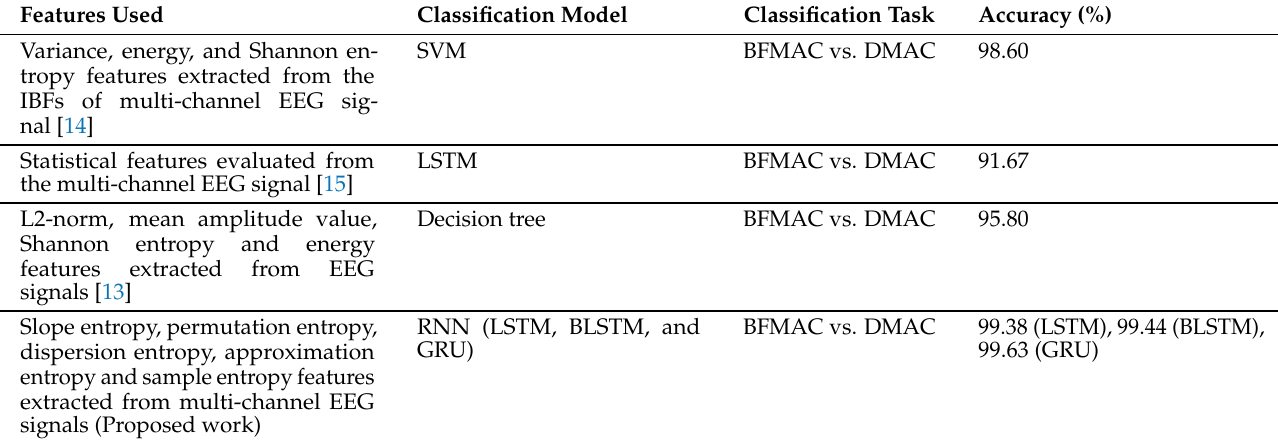
Table 11. Comparison with existing methods for the automated mental arithmetic cognitive task classification using multi-channel EEG signals from the same